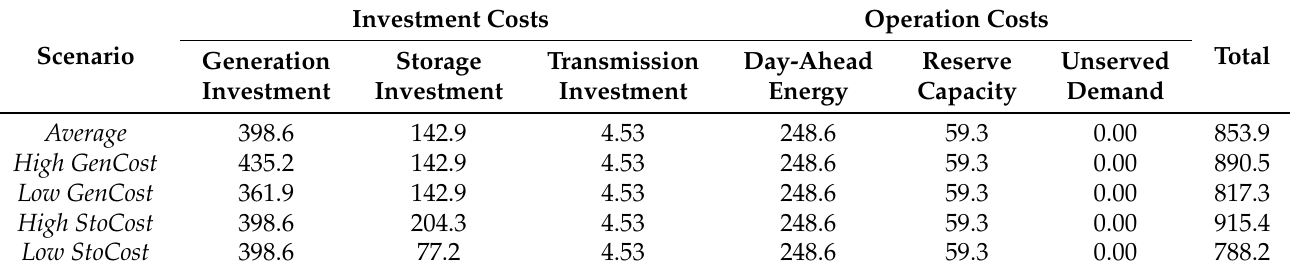
Table 17. Cost per investment-related scenario (million e